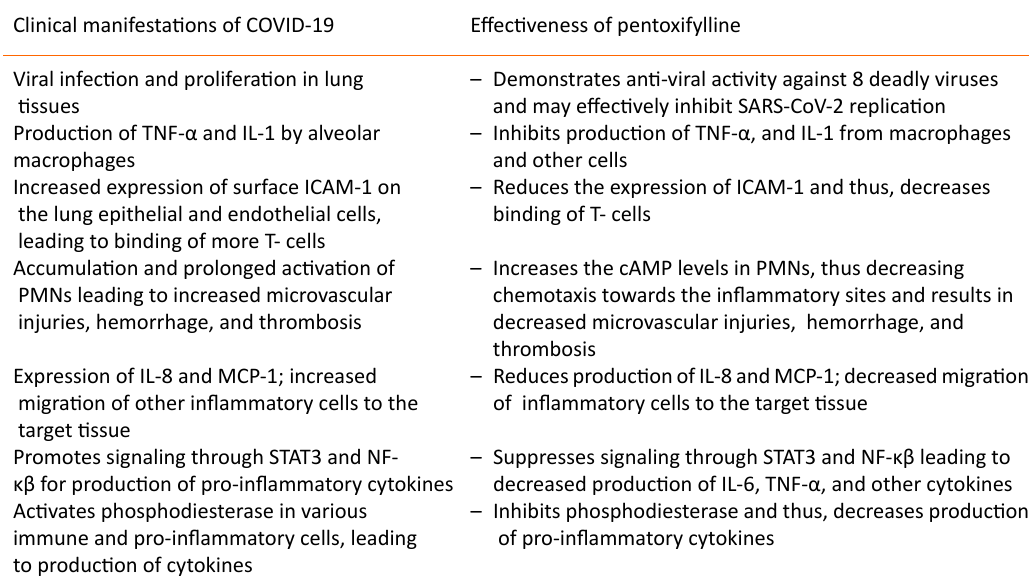
Table 1. Summary of the action of pentoxifylline against clinical manifestations of SARS-CoV-2 in COVID-19 patients Clinical manifestations of COVID-19 Effectiveness of pentoxifylline Viral infection and proliferation in lung – Demonstrates anti-viral activity against 8 deadly viruses tissues and may effectively inhibit SARS-CoV-2 replication Production of TNF-α and IL-1 by alveolar – Inhibits production of TNF-α, and IL-1 from macrophages macrophages and other